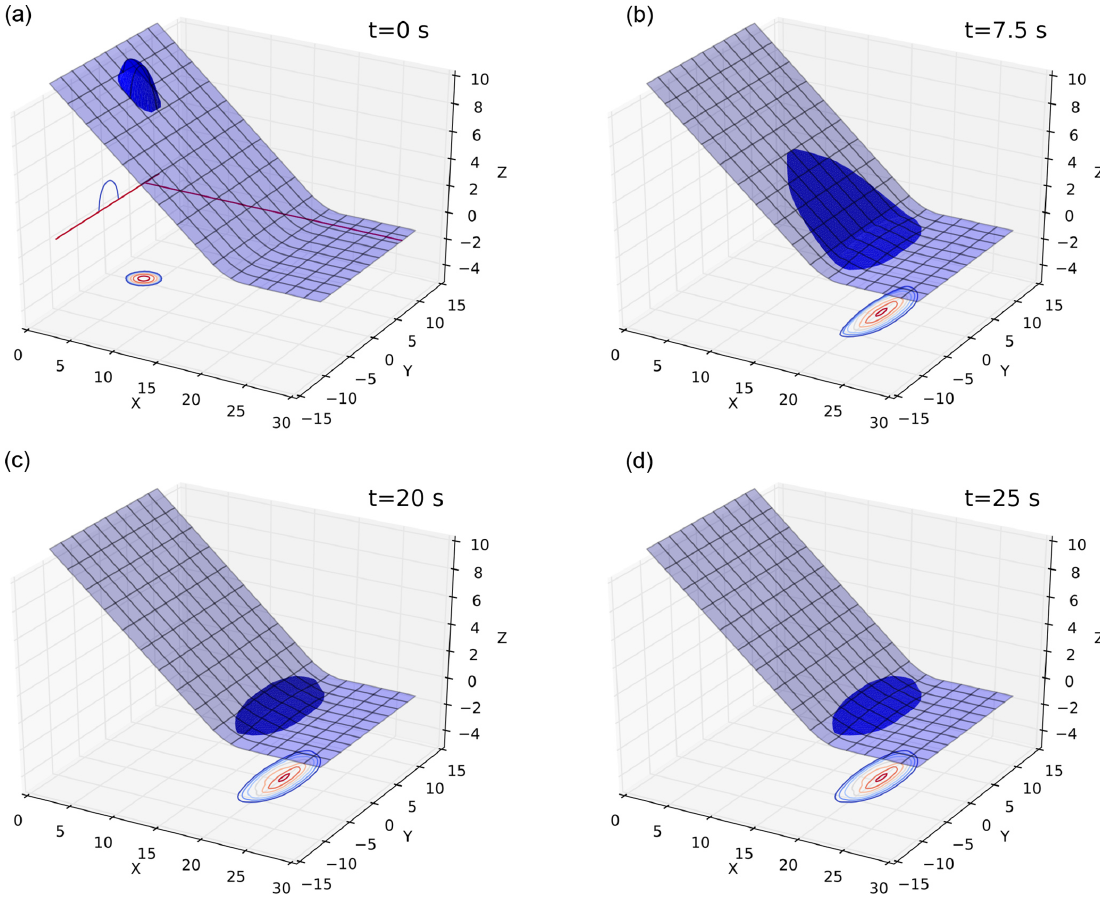
Figure 5. Numerical simulation of two-dimensional pyroclastic avalanche with Voellmy–Salm friction. The contour plots on the bottom plane of each panel represent constant values of the thickness of the flow, whose free surface is represented in blue. The outermost contour on the bottom plane corresponds to a thickness of 0.06m, and thus the thinner portion of the flow is not represented by the contour plot. A visual comparison between the two bottom plots highlights the fact that a steady condition has been